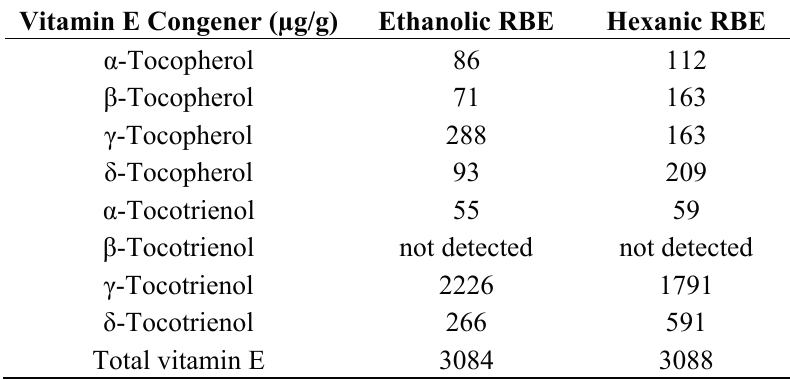
Table 1. Concentrations of vitamin E congeners (µg/g) in ethanolic and hexanic rice bran extracts (RBE) measured by high-performance liquid chromatography (HPLC) with fluorescence